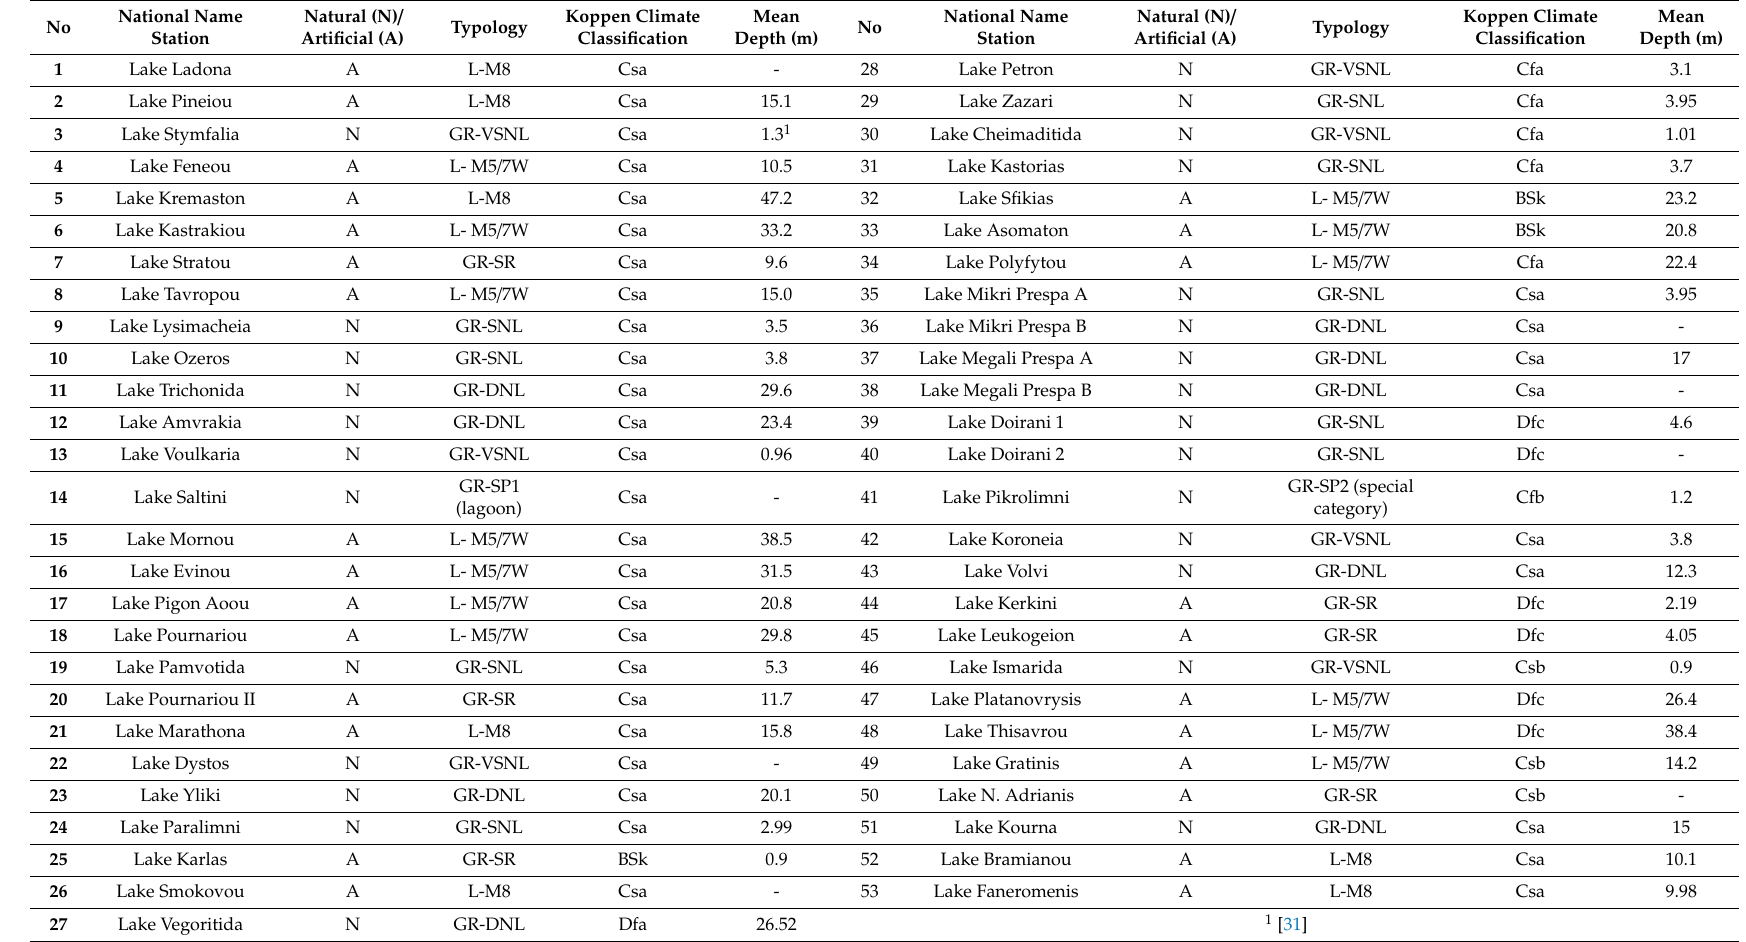
Table 1. General characteristics of the lakes comprising the National Lake Network Monitoring in Greece (Water Framework Directive (WFD)